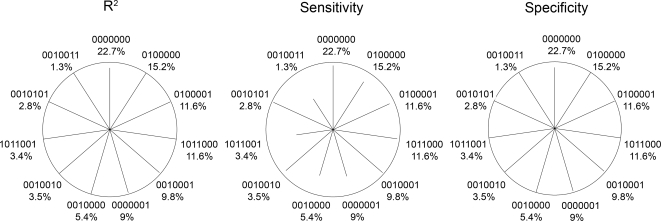
Haplotype-specific error measures:Star plots for the CAPN10 displaying the R2, the sensitivity or the specificity as in Figure 4. The angle between lines is given by 360° divided by the number of frequent haplotypes (frequency 3 1%) to accommodate for the large number of loci (L = 7).